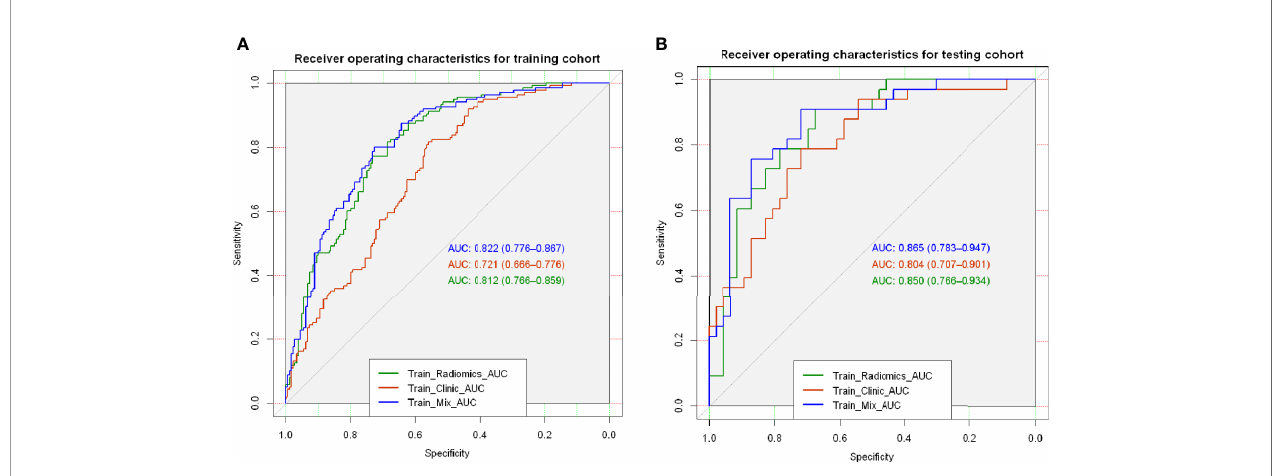
FIGURE 4 | Performances of the three models in the training (A) and test (B) groups.